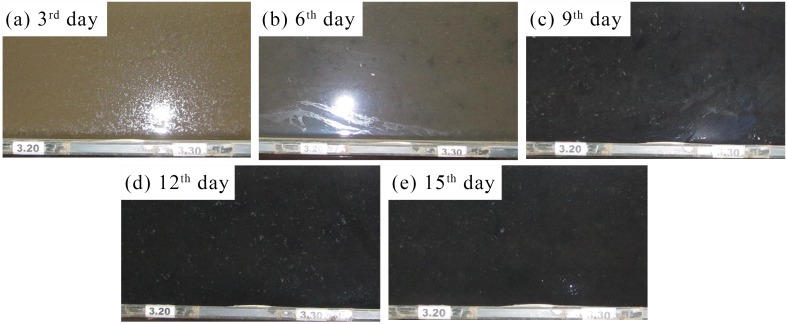
Typical photographs of the biofilm growth with the corresponding cultivation period.The number in each image represents the cultivation period, i.e., images (a)-(e) correspond to cultivation periods of 3, 6, 9, 12 and 15 days, respectively.